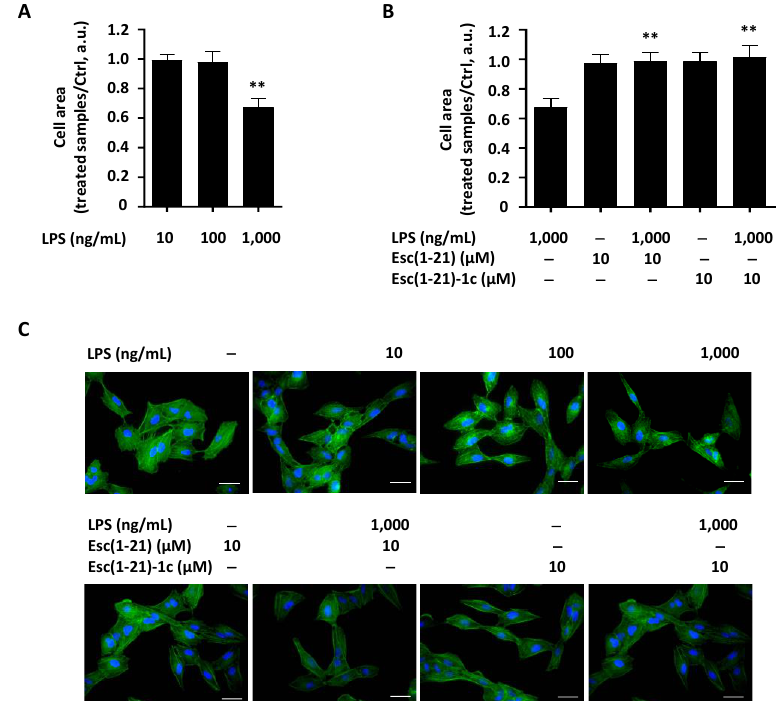
Figure 5. Dimensional analysis of A549 cells after 24 h treatment with the LPS at different concentrations ( A ) or following stimulation with Esc peptides alone or in combination with the LPS at 1000 ng/mL ( B ). Cells were stained with phalloidin and analyzed by ImageJ program. The results are reported as the ratio between the area of treated and untreated Ctrl samples ± SEM. The level of statistical significance between Ctrl and LPS-treated samples or between the LPS in combination with peptides and the LPS alone was determined by one-way ANOVA analysis and is indicated as follows: ** p < 0.01. ( C ) Representative micrographs showing the effects of the LPS, peptides, or their combination on A549 cells dimensions. Bars are 20 µ m